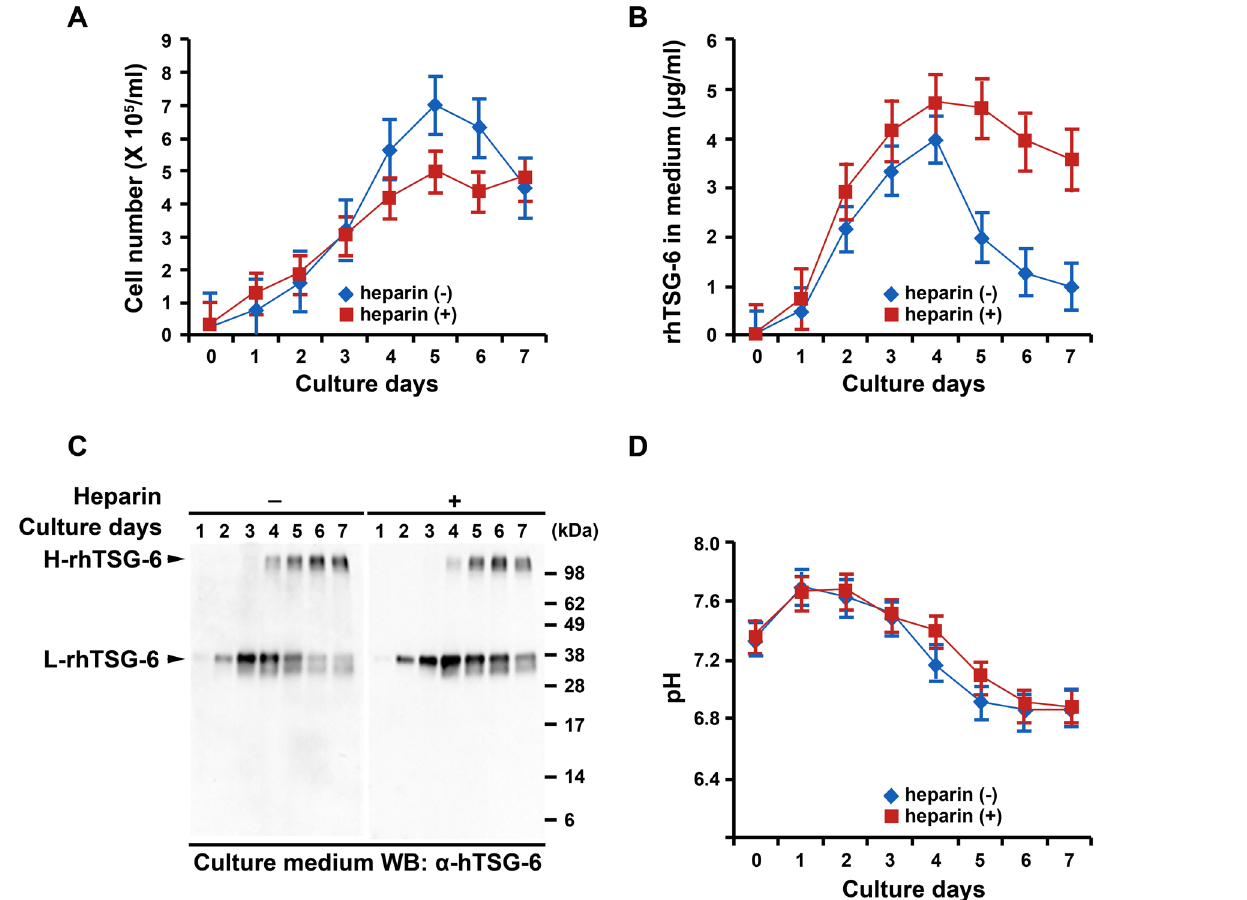
Fig 2. Addition of heparin to medium improved yield of rhTSG-6 in spinner cultures. (A) Effect on number of rhTSG-6/CHO-S cells. (B) Effect on yield of rhTSG-6. (C) Effect on yields of protein aggregates/complexes (H-rhTSG-6) and monomeric rhTSG-6 (L-rhTSG-6). Western blots with antibodies to hTSG- 6 on medium from day 4 cultures of rhTSG-6/CHO-S cells. (E) Effects on pH of medium. Values are mean ± S.D. of 3 replicates of each sample in (A), (B), and